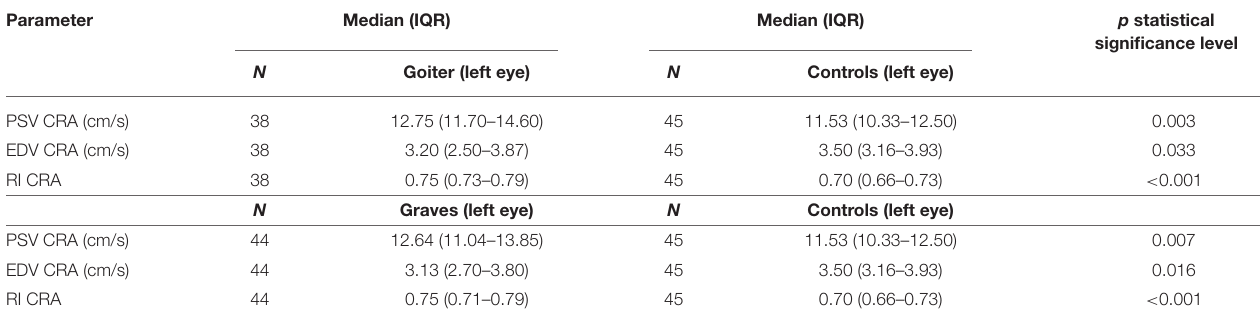
TABLE 4 | Comparison of blood flow parameters (PSV, EDV, RI) in central retinal artery in Graves’ disease, toxic nodular goiter, and healthy controls. Parameter